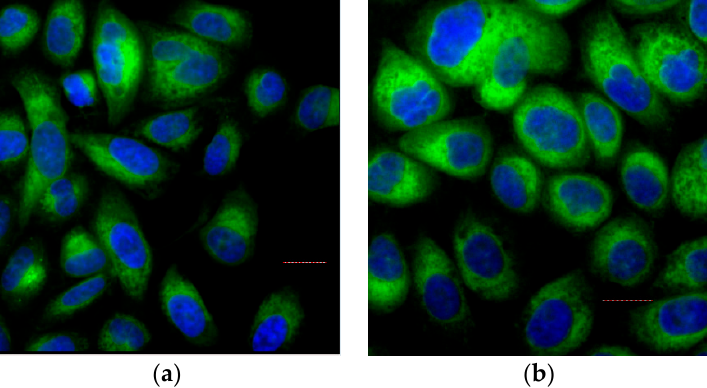
Figure 8. Microscopic images of stained PC-3 cells. The investigated compounds 3 and 5 are shown in green. Both compounds were applied at 10 µM concentrations. The cell nuclei were counterstained with 1 µg/mL DAPI and are marked blue. The dashed line represents 20.3 µm. ( a ) Staining with carbazole 3 ; ( b ) Staining with caged compound 5 .